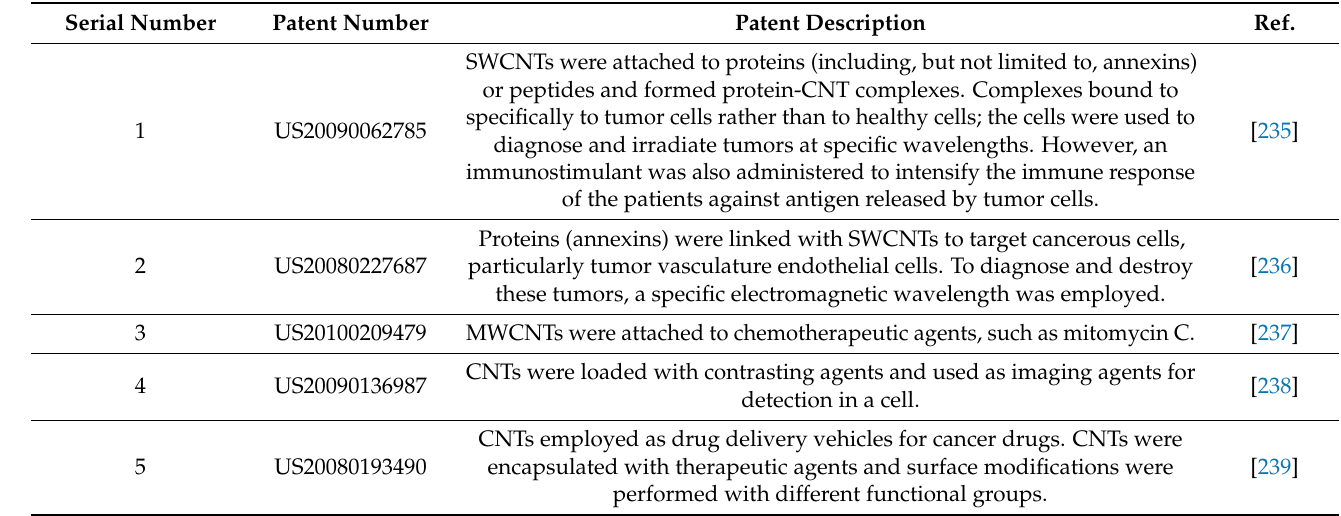
Table 10. Some foremost patents describe CNTs used in the delivery of therapeutics, imaging and in disease